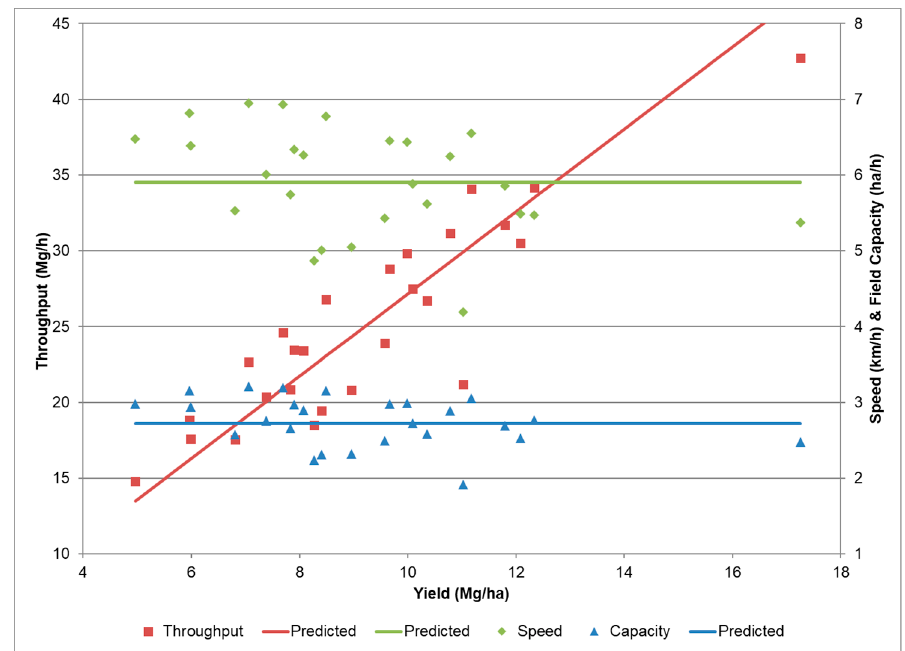
Figure 4. The relationship of the performance data to switchgrass yield from Field 6. Productivity data does not include time spent wrapping and ejecting the bale. The individual points are observations from field data. The solid lines (green—effective speed, red—throughput, blue—effective field capacity) are predicted [4] assuming values of v e = 8.0 km/h, E f = 0.74, and W s = 4.6 m.